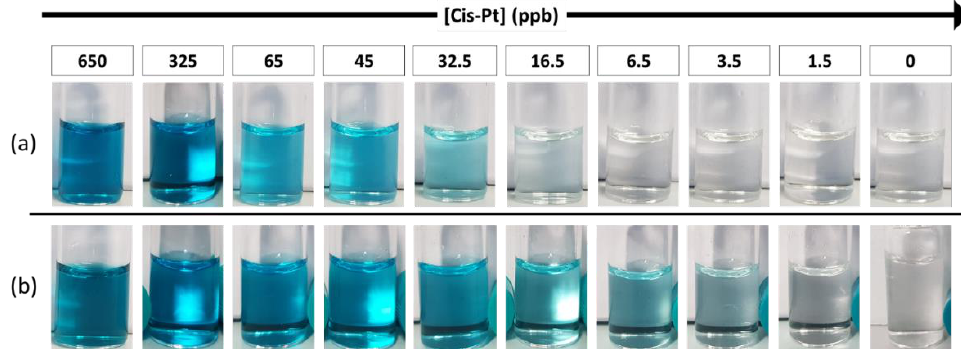
Figure 2. Representative colorimetric results of the assay, after 5 min color development. ( a ) Color change obtained at different concentrations of cisplatin (LOD ~30 ppb) in the standard configuration. ( b ) Colorimetric results in the enhanced configuration of the test (LOD ~3 ppb).